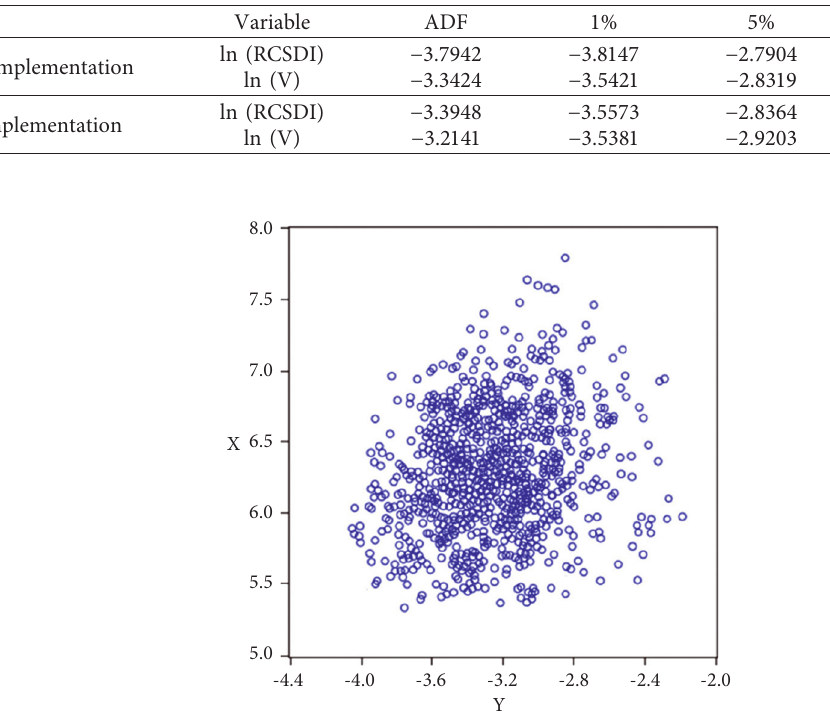
Figure 4: Relationship between ln (RCSDI) and ln (V) before the